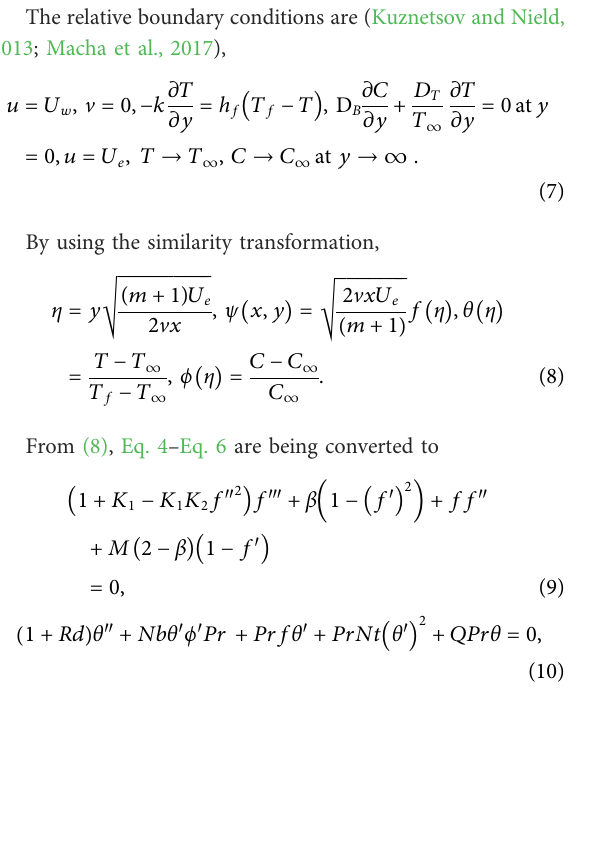
FIGURE 27 Variations of Nu x Re − 1/2 x via Nb and Rd